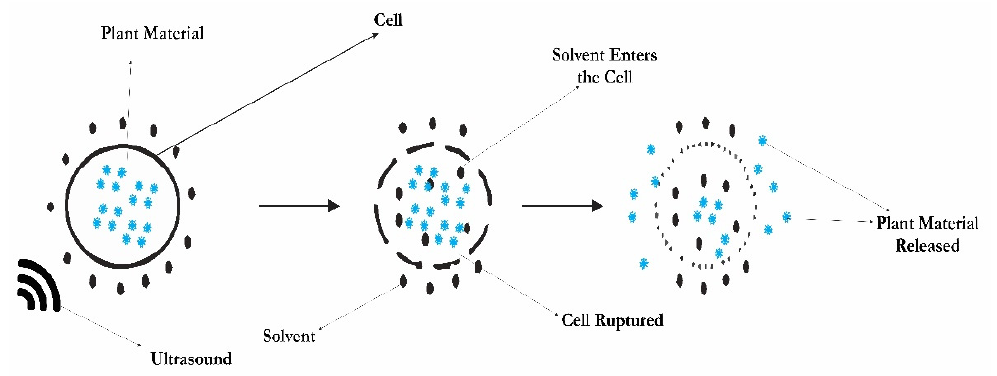
Figure 4. Possible extraction mechanism of ultrasound.